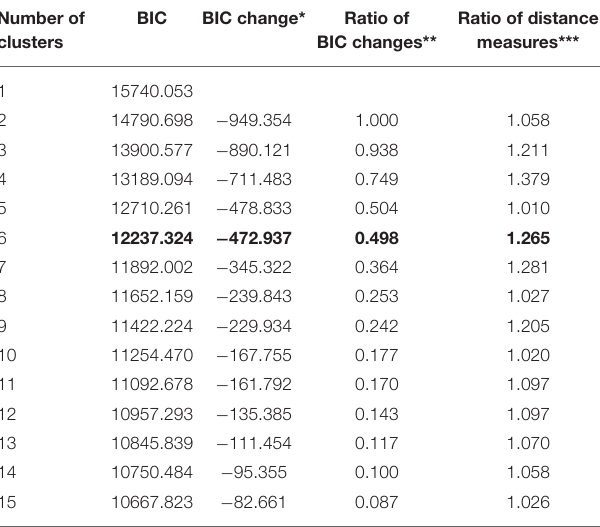
BIC, Bayesian Information Criterion. * The changes are from the previous number of clusters in the table. ** The ratios of changes are relative to the change for the two cluster solution. *** The ratios of distance (log-likelihood) measures are based on the current number of clusters against the previous number of clusters. Bold values represents the six cluster solution – the most appropriate